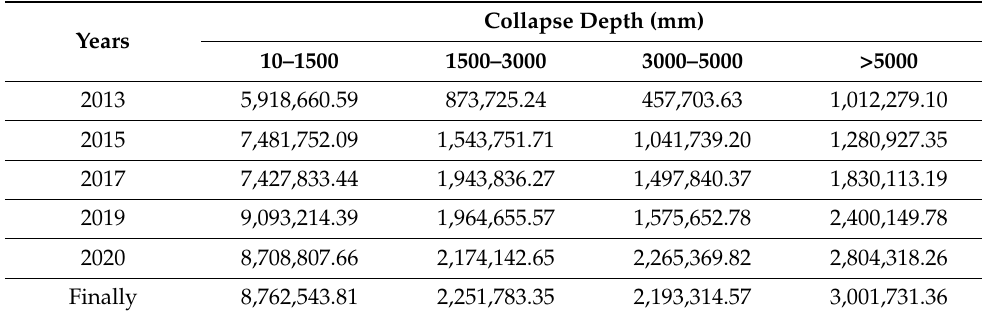
Table 4. Statistics of collapsed area of mine A in each period (m 2